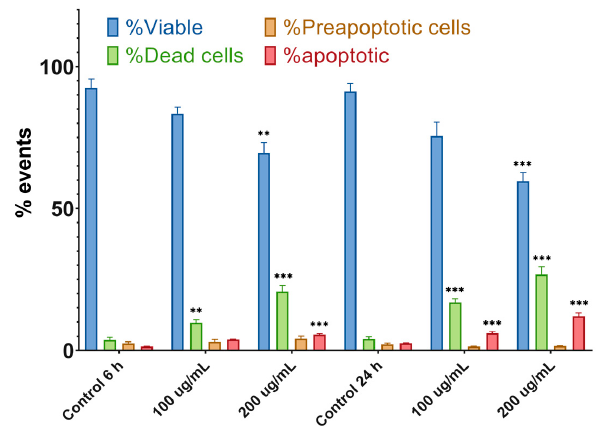
Figure 6. The frequency of distribution of viable, dead, pre-apoptotic and apoptotic cells in UBE-treated CAL 27 cell cultures, at concentrations of 100 and 200 µg/mL. These results represent the mean ± SE of three independent experiments (** p < 0.01 and *** p < 0.001) when comparing the effects of UBE with the untreated control (t-test).